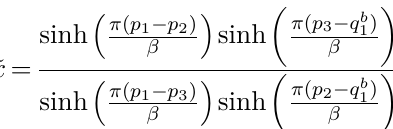
Figure 20 . The endpoints of the intervals A and B in the two BCFT 2 copies are identified as p 1 = p 8 = r I + (cid:15) , p 2 = p 7 = r 2 , p 3 = p 6 = r 3 and p 4 = p 5 = r O − (cid:15) . The other points q b are the image points of p 1 and p 8 respectively with respect to the b -boundary at p I = r I and q a = r O + (cid:15) , q b = r O + (cid:15) are the image points of p 4 and p 5 respectively with respect to the a -boundary 4 5 at p O = r O